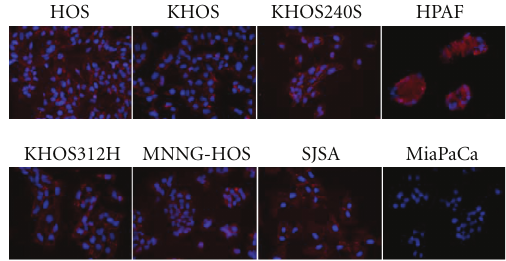
Figure 2: Surface ALCAM expression in osteosarcoma cell lines. Fluorescent immunohistochemistry showing membranous ALCAM expression in osteosarcoma cell lines in comparison to a known ALCAM expressing pancreatic cancer cell line, HPAF (pos- itive control), and ALCAM negative cell line, MiaPaCa. ALCAM binding shown in red (Alexa Fluor 564) and nuclei counterstained with DAPI (20x